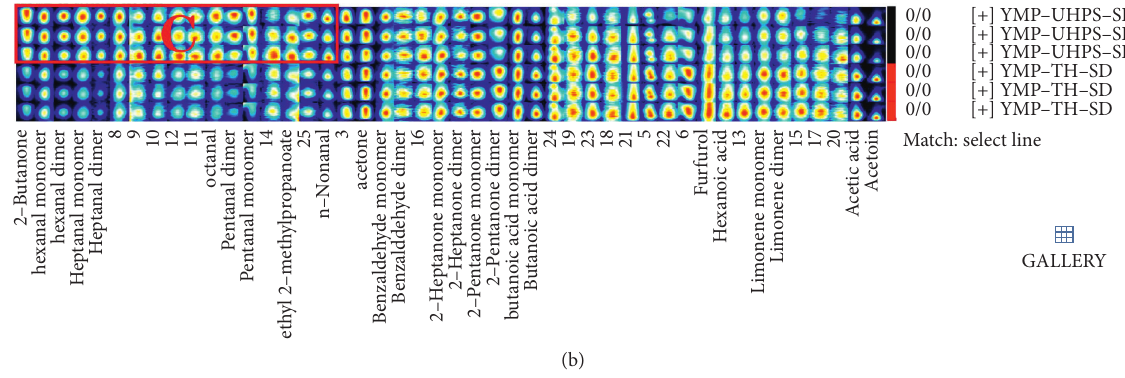
Figure 3: Fingerprint of volatile compounds of